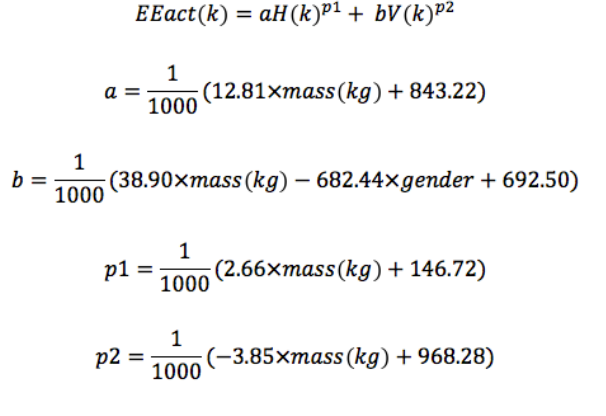
Figure 1. Resulting activity energy expenditure (EEact) using generalized nonlinear